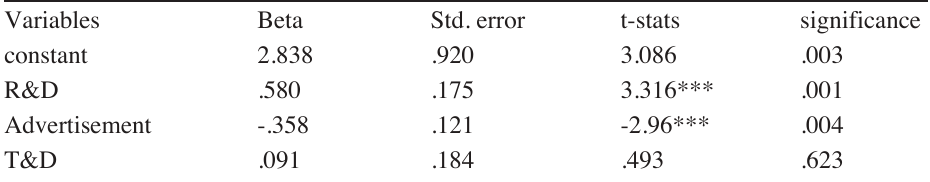
Table 6. Regression Results for Pharmaceutical